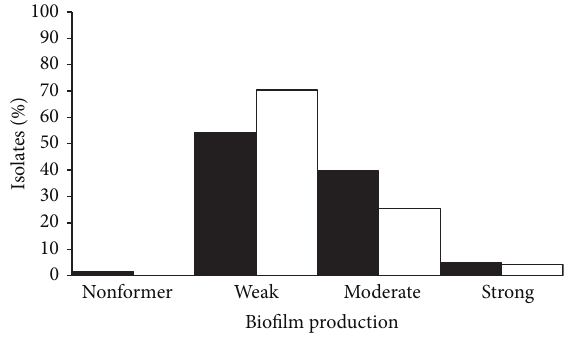
Figure 1: Biofilm production by clinical ( ◻ ) and food ( ◼ ) isolates of L. monocytogenes at 37 ∘ C during 24 h.